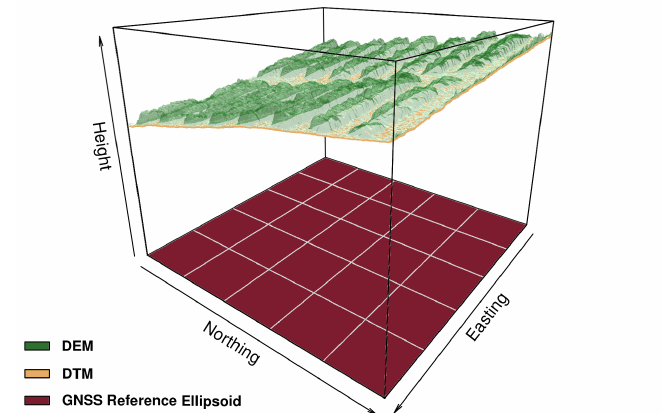
Visualization of DEM and DTM altitudes relative to a commonly shared GNSS reference ellipsoid (red surface). While the DEM represents a surface model of the experimental site (green surface), the DTM represents the surface of the ground. The DTM was approximated by interpolation of ground classified DEM pixels (yellow surface). Absolute crop heights are derived by subtraction of the two surface